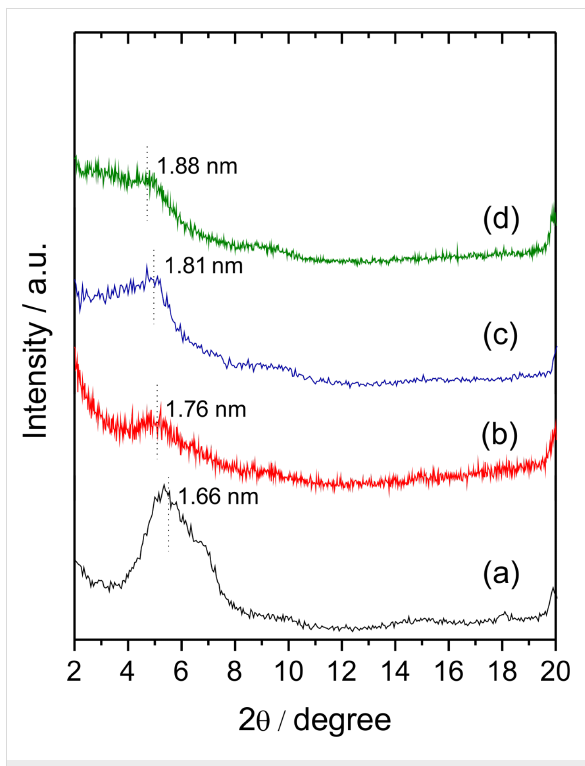
Figure 6: XRD patterns of (a) EXT-MMT16 biohybrid and the EXT–MMT/PCT biohybrids prepared with different PCT phases recov- ered from (b) 0.06, (c) 0.3 and (d) 1.5 g of zein in 80 mL of pure